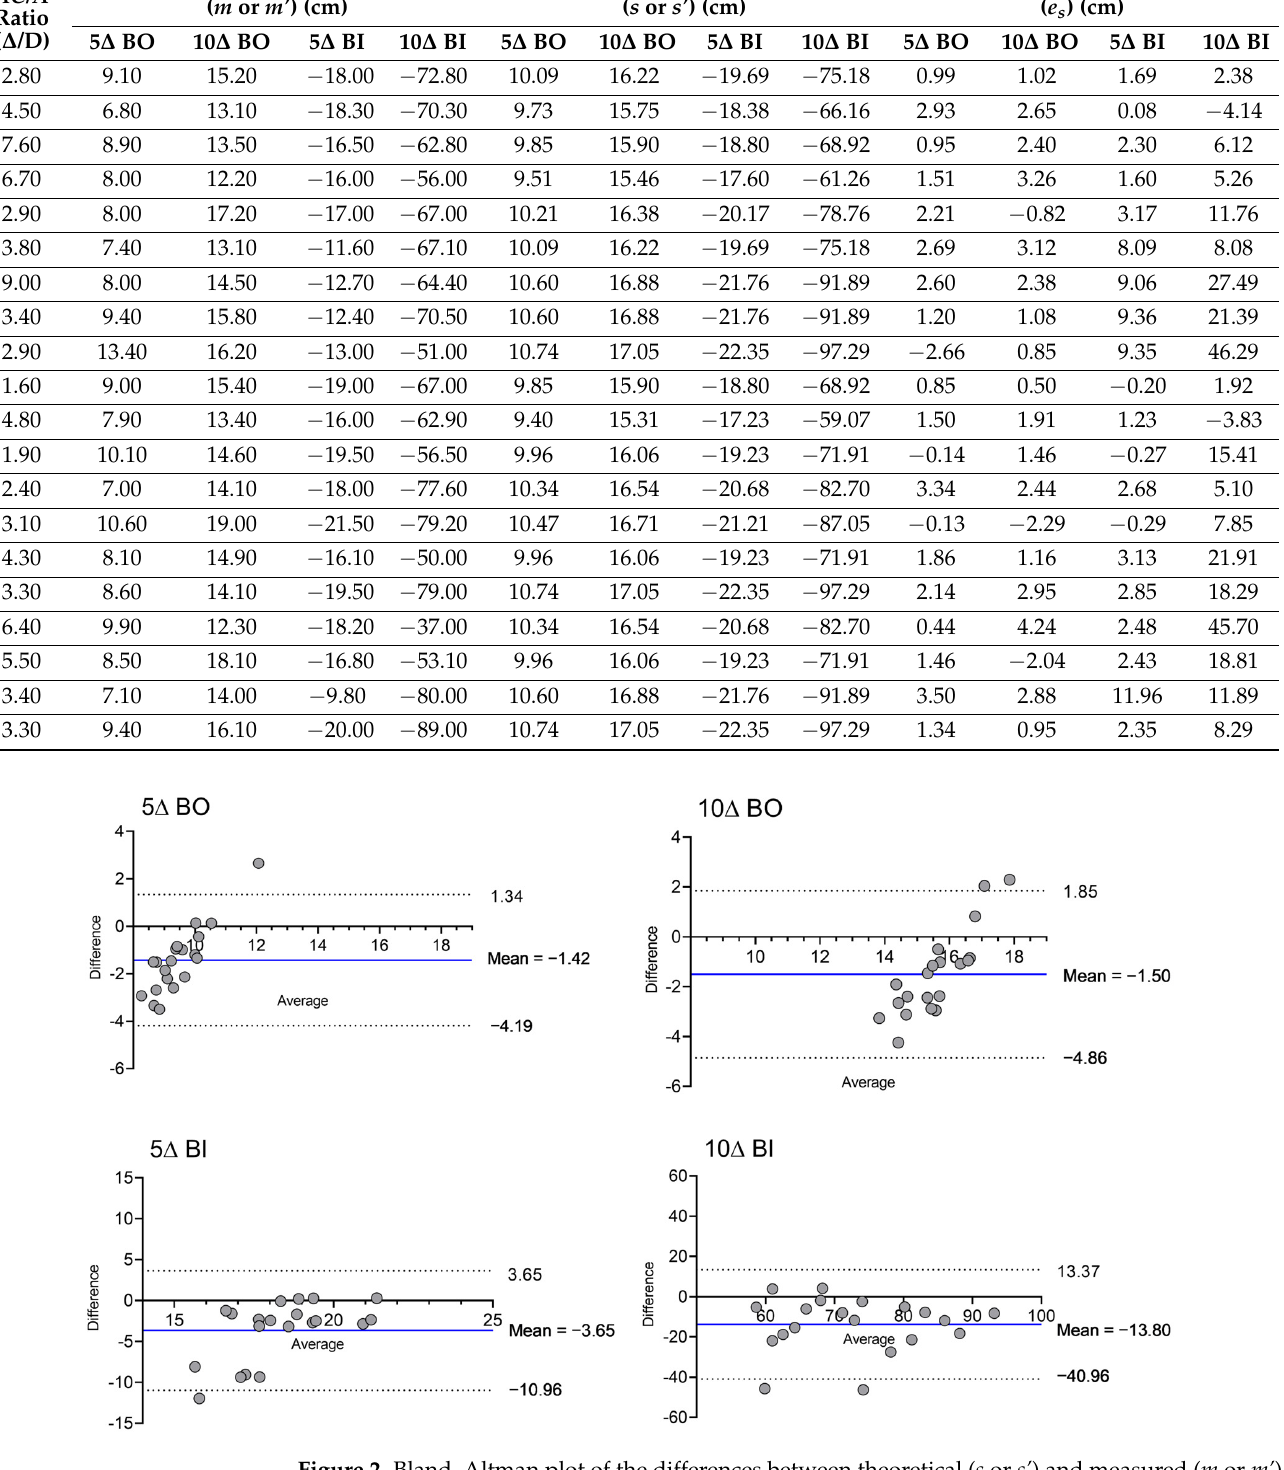
Figure 2. Bland–Altman plot of the differences between theoretical ( s or s’ ) and measured ( m or m’ ) distances to the target stimuli for each vergence demand (BO: Base out; BI: Base in). For visualization purposes, axes are not drawn at the same scale. Individual data points are shown as full bullets.